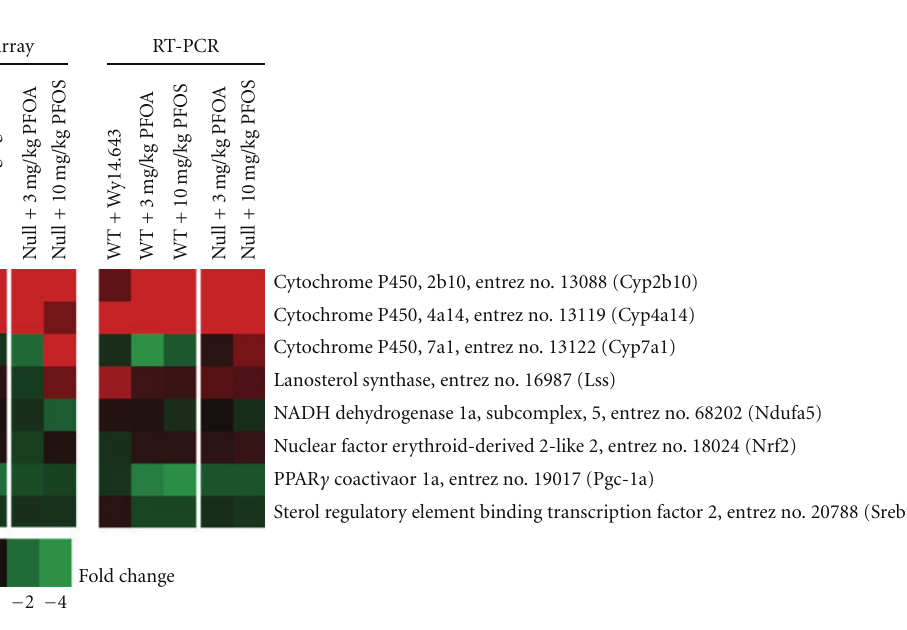
Figure 4: Microarray and Real-time PCR analysis of selected genes. Data from both assays were in close agreement. Small changes in Ndufa5 expression, a gene which encodes for a subunit of mitochondrial respiratory chain complex I, could not be confirmed by RT-PCR. As predicted based on microarray analysis, PFOS did not appear to up-regulate the expression of Srebf2 , Ppargc 1 a (Pgc-1a) , or Nfe2l2 ( Nrf2 ) in WT or Null mice. Red or green correspond to average up- or down- regulation,